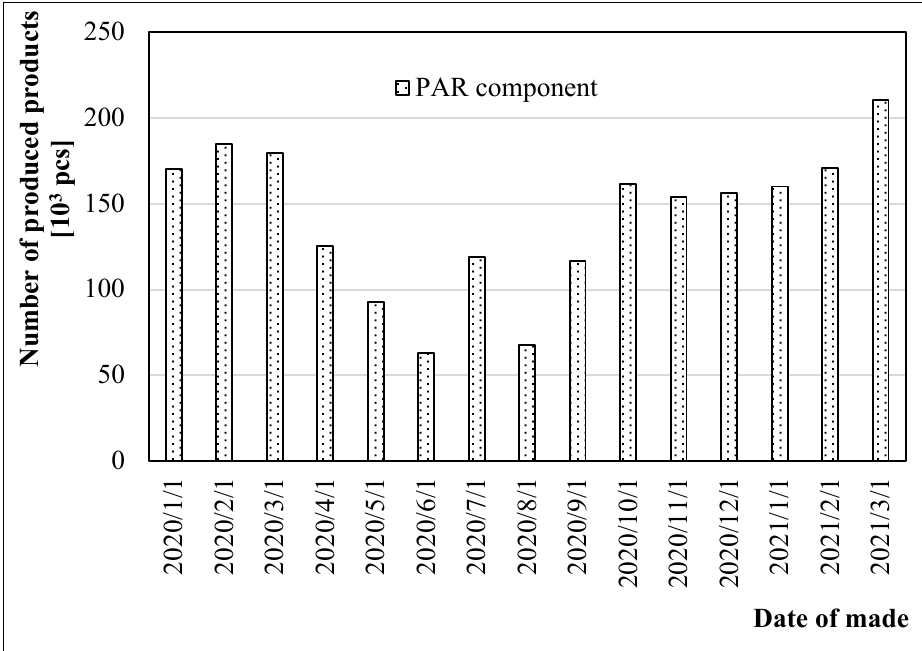
Figure 4. Production for the period of 2020–2021.